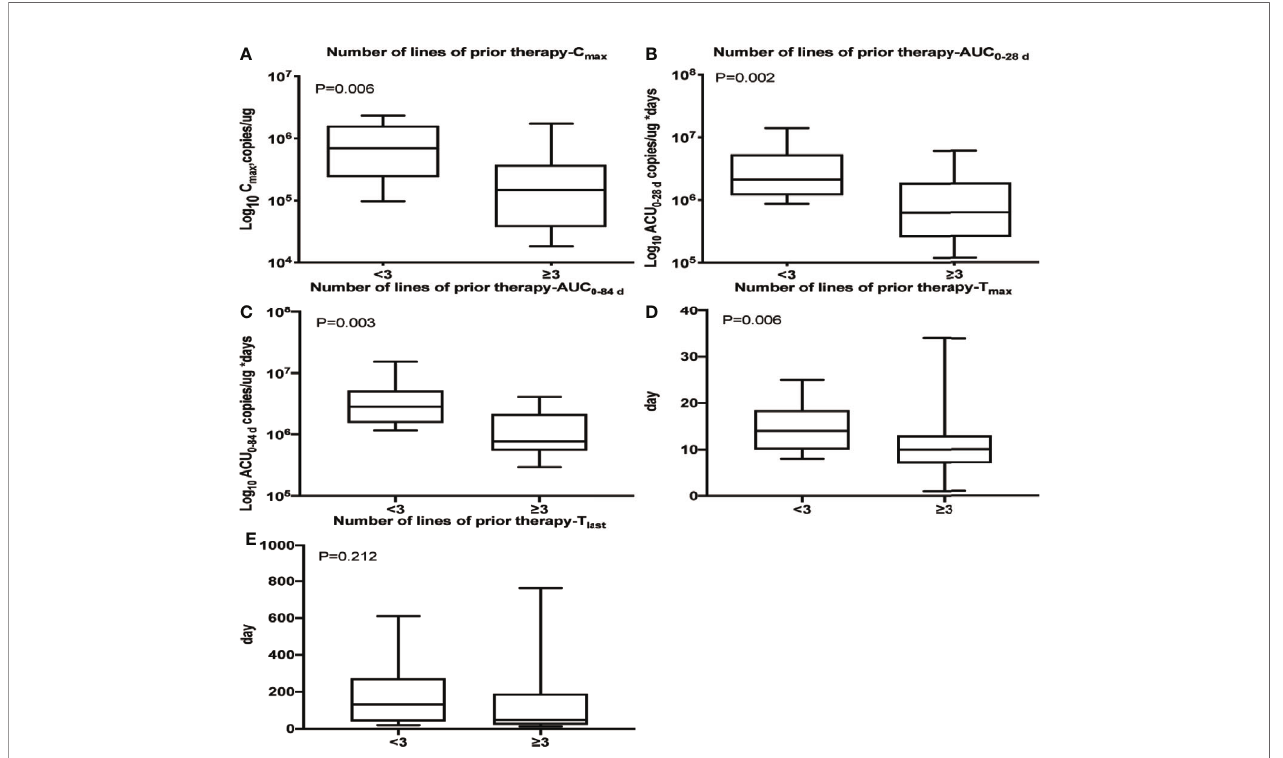
FIGURE 2 | Relationship between the number of prior treatment lines and cellular kinetics. (A) Patients who had received three or more lines of prior treatment had a lower C max (P = 0.006). (B) Patients who had received three or more lines of prior treatment had a lower AUC 0 – 28 d (P = 0.002). (C) Patients who had received three or more lines of prior treatment had a lower AUC 0 – 84 d (P = 0.003). (D) Patients who had received three or more lines of prior treatment had a lower T max (P = 0.006). (E) No difference was observed in T last among patients with different numbers of lines of prior treatment (P =